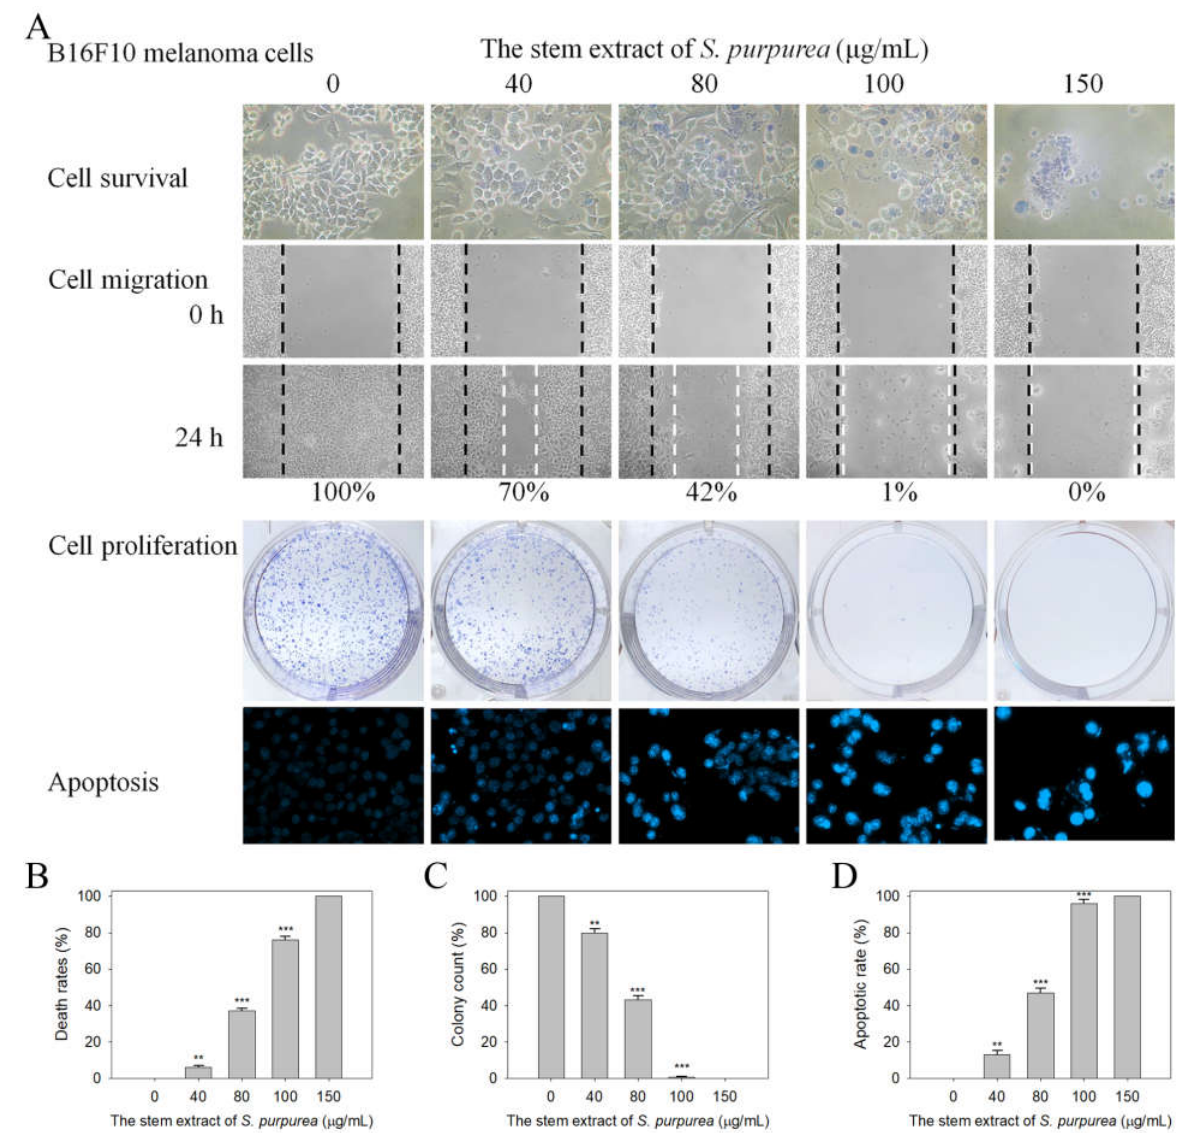
Figure 9. The cytotoxic effects of the stem extract. ( A ) Effects on cell survival, migration and proliferation, and apoptosis. ( B ) Trypan blue dye exclusion staining results. B16F10 cells incubated with the stem extract of S. purpurea at concentrations of 40, 80, 100, and 150 µ g/mL. ( C ) Clonogenic formation assay results. Pretreatment with the stem extract of S. purpurea significantly suppressed the proliferation and colony formation of B16F10 cells. ( D ) Hoechst staining results. Apoptosis induced by the stem extract of S. purpurea with DNA fragmentation was observed in B16F10 cells. ** p < 0.01 and *** p < 0.001 compared with the control